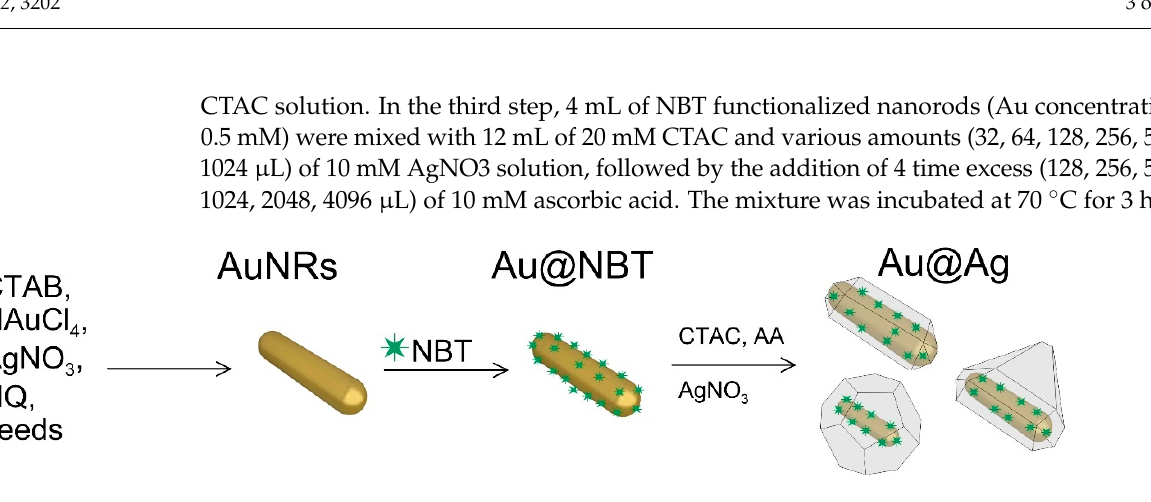
Figure 1. Scheme for the synthesis of Au@Ag nanorods with embedded Raman reporters.